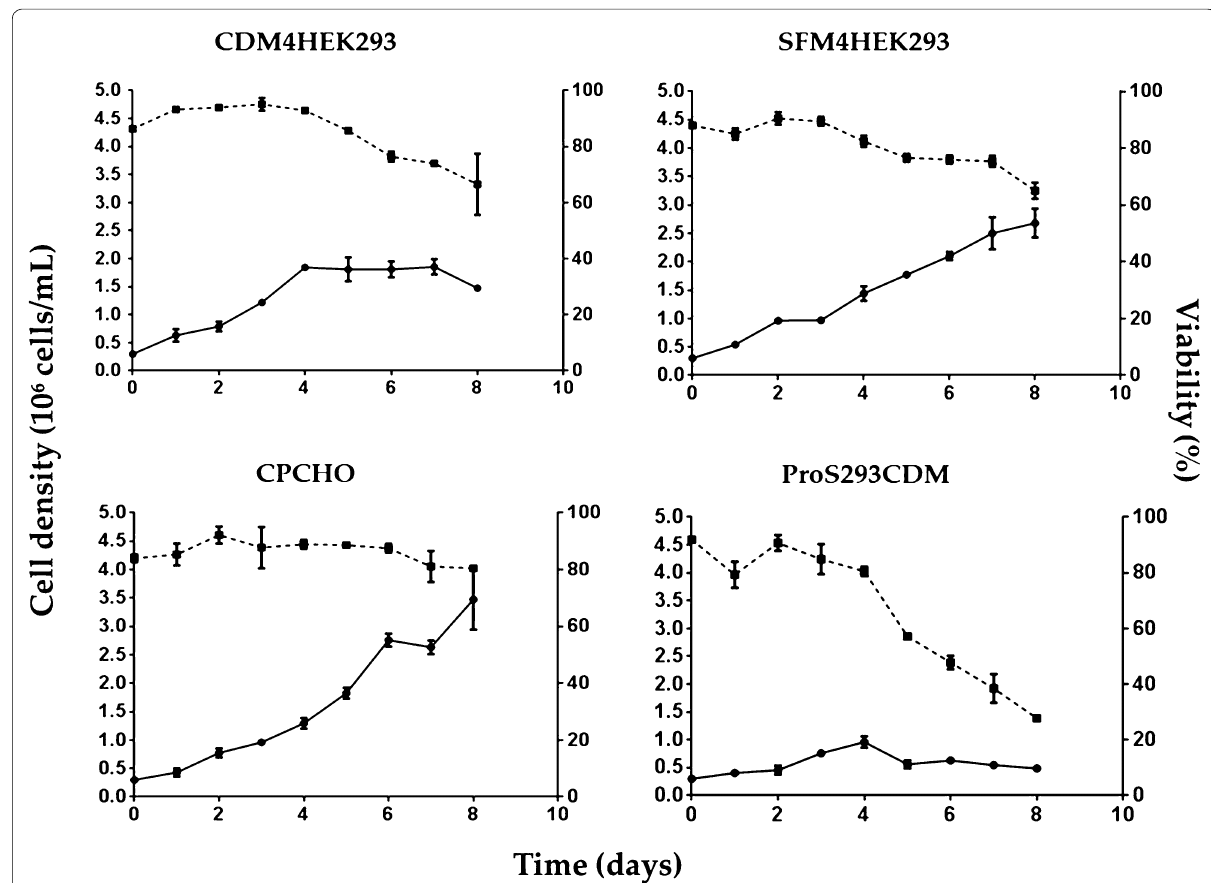
Fig. 1 Cell density (circle‑solid line) and viability (square‑dashed line) profiles of HEK‑293‑E2‑CD154 cell cultures with the four commercial media evaluated. a CDM4HEK293 culture media, b SFM4HEK293 culture media, c CPCHO culture media, d ProS293CDM. Each point represents the average from four determinations (two cell counts from two biological replicates). Error bars represent standard deviations